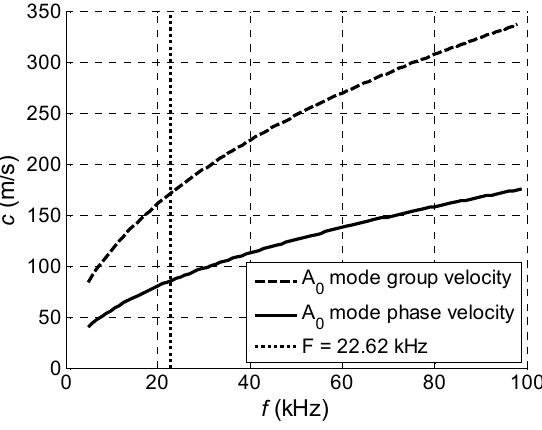
Figure 24. The calculated phase and group velocity dispersion curves for d = 0.13 mm thickness clear PVC film.